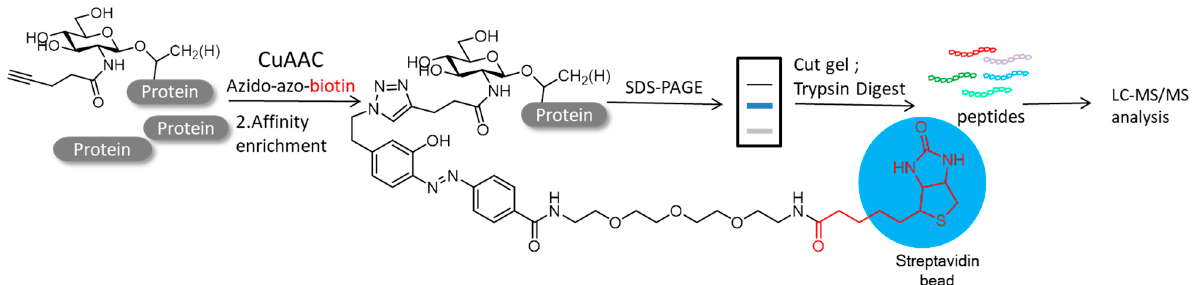
Figure 7. GlcNAlk is metabolized and integrated into NIH-3T3 cells. After lysis, the protein was treated with azido-azo- biotin for CuAAC. GlcNAlk modified proteins were isolated by affinity enrichment based on streptavidin beads.